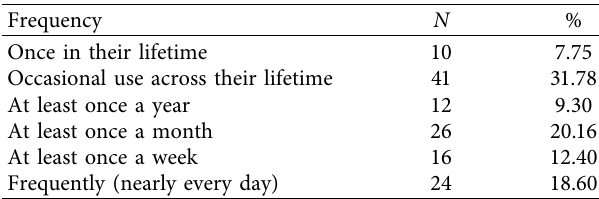
Table 1: Frequency of cannabis use within the sample of 129